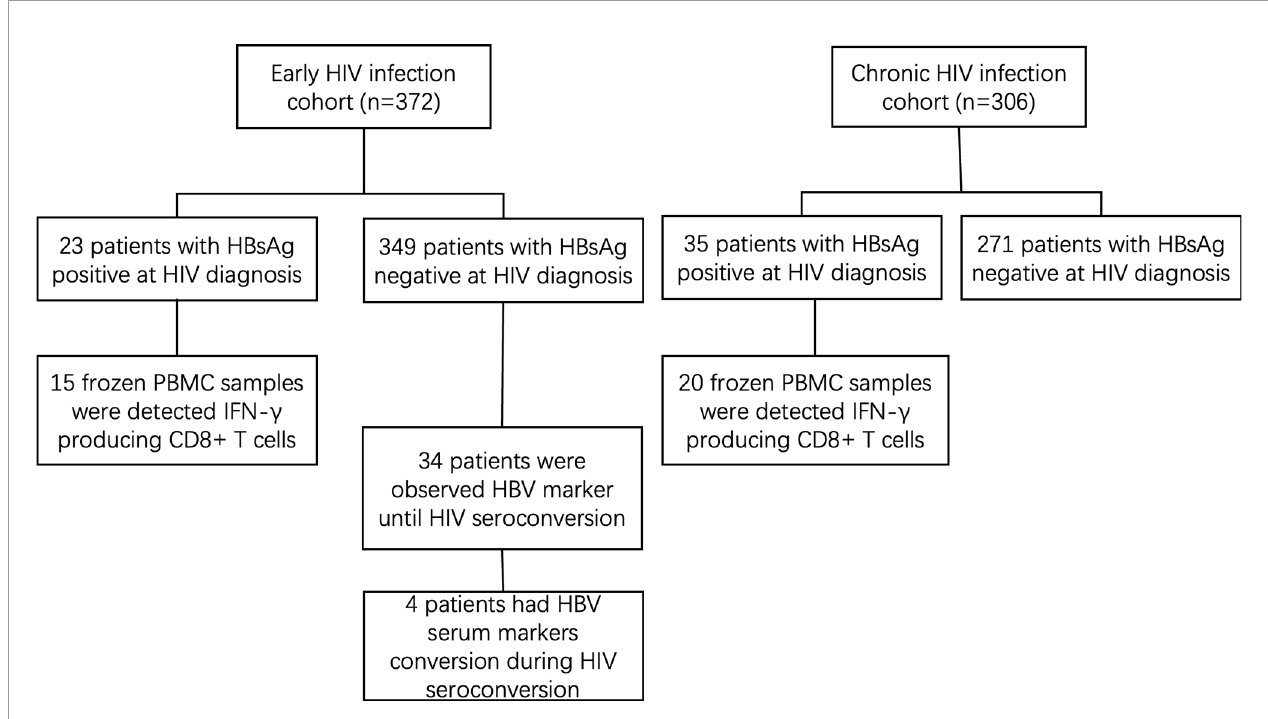
FIGURE 1 | Flow chart of the study